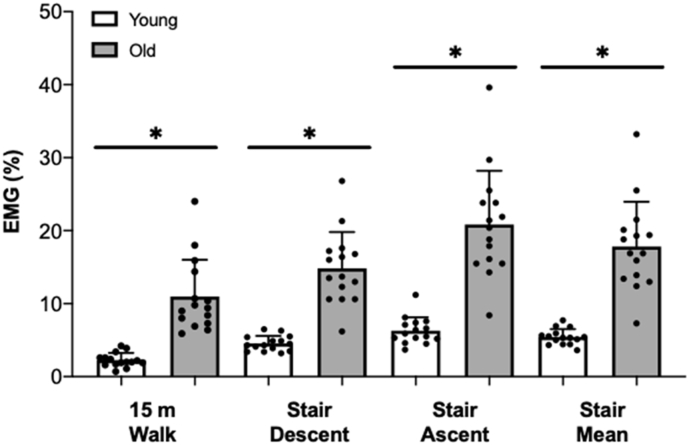
Quadriceps muscle EMG activity during activities of daily living.Peak muscle EMG activity of the quadriceps during activities of daily living (walking, stair descent, stair ascent and stair mean) in young (white bars) and old (grey bars) adults, with values presented as means ± standard deviation. * Indicate significant (P < 0.01) differences in muscle EMG activity (EMG, %) between groups. EMG, Electromyography.